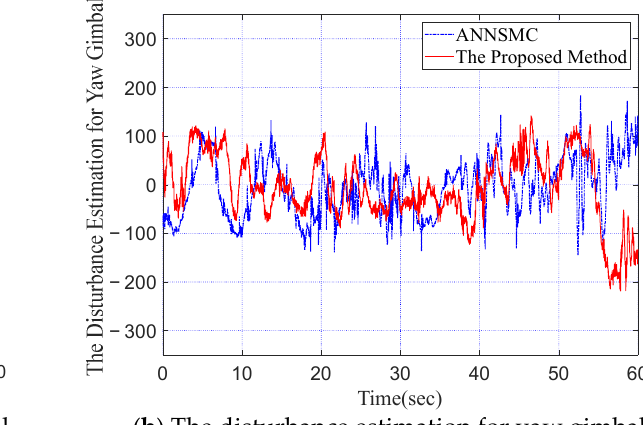
Table 3. Comparisons of ANNSMC and the proposed method in Case 1. Figure 10. The disturbance estimations of the two controllers in Case 1.